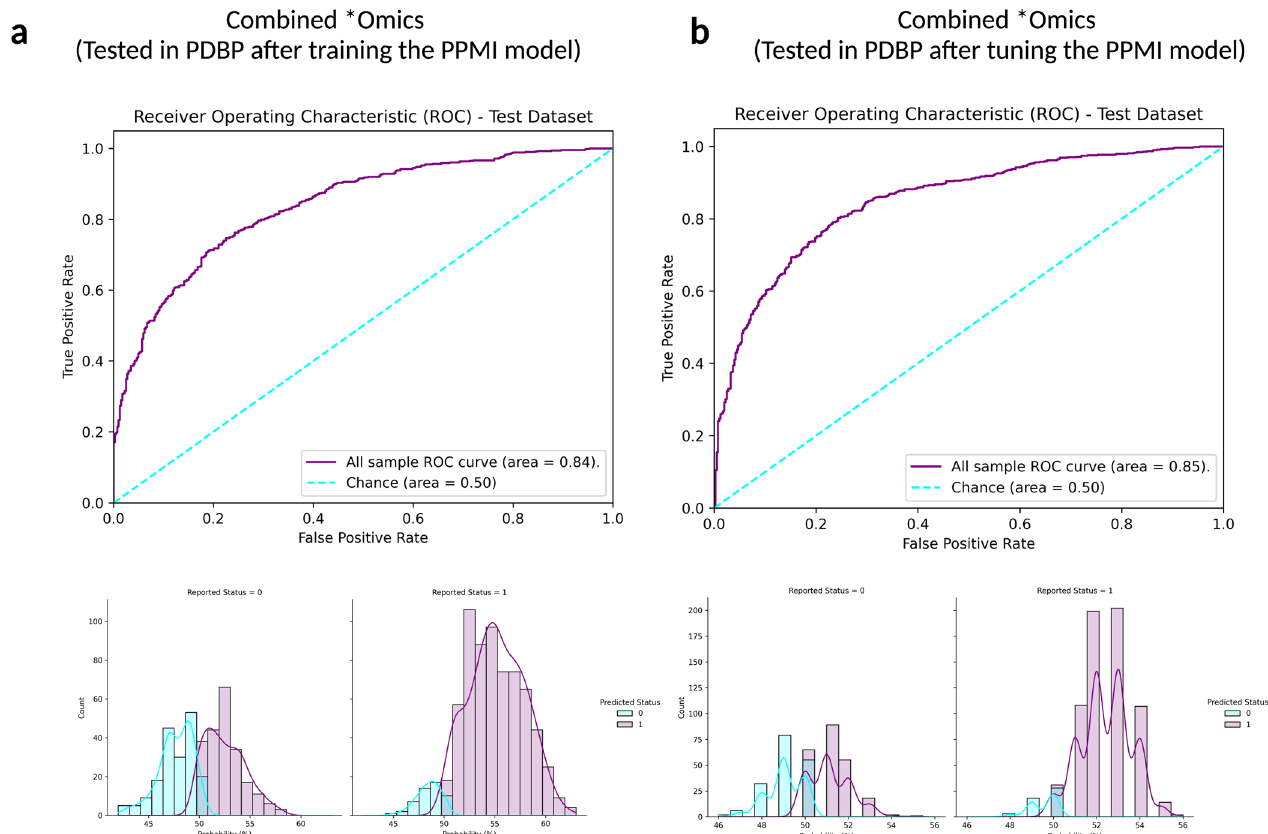
Fig. 3 Receiver operating characteristic and case probability density plots in the external dataset (PDBP) at validation for the trained and then tuned models at default thresholds. Probabilities are predicted case status (r1), so controls (status of 0) skews towards more samples on the left, and positive PD cases (status of 1) skews more samples on the right. a Testing in PDBP the combined *omics model (genetics p value threshold = 1E-5, transcriptomics p value threshold = 1E-2, and clinico-demographic information) developed in PPMI prior to tuning the